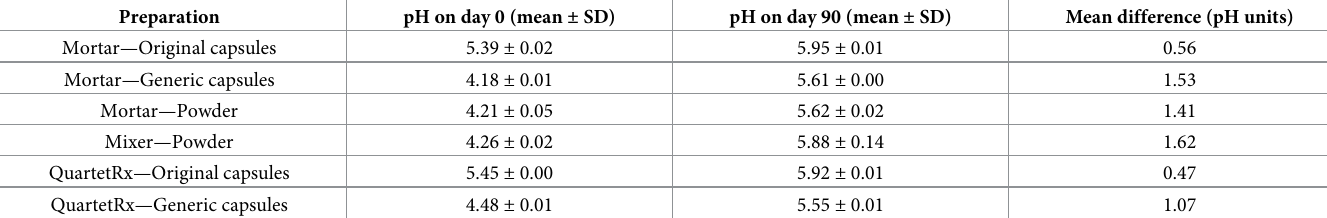
Table 2. Comparison of pH